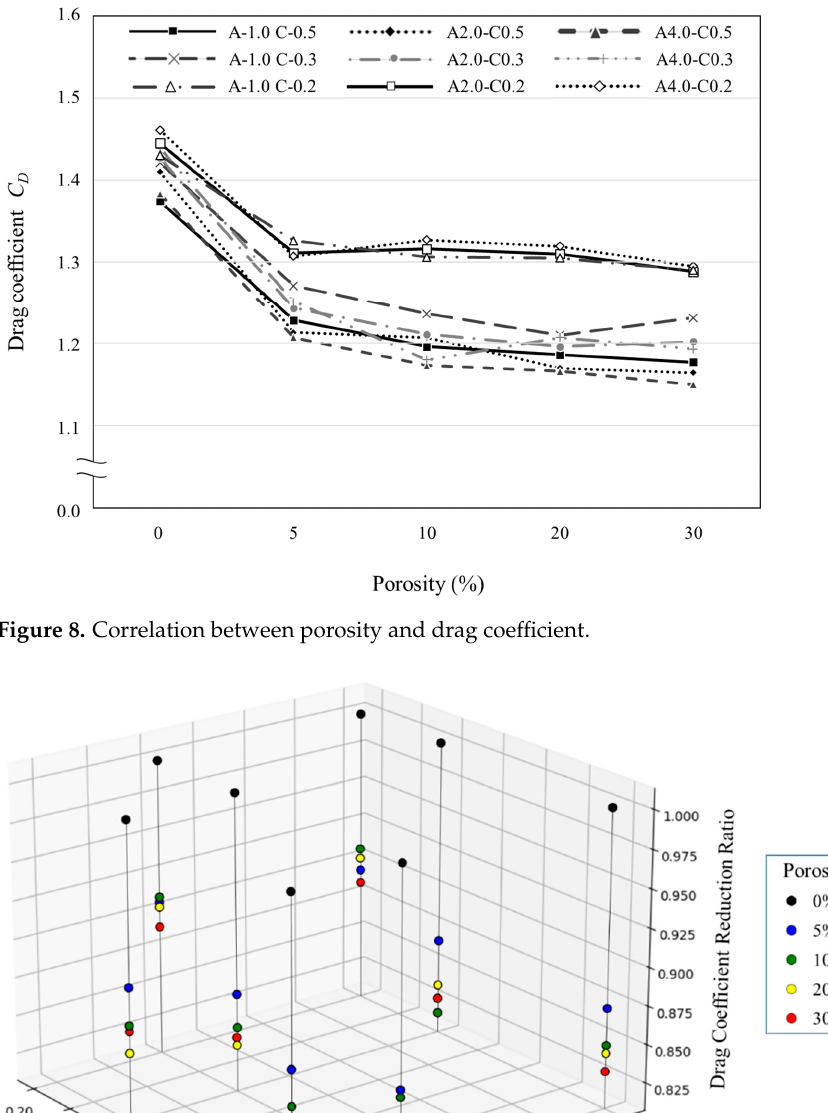
Figure 10. Wind pressure distribution of perforated road sign by wind speed.